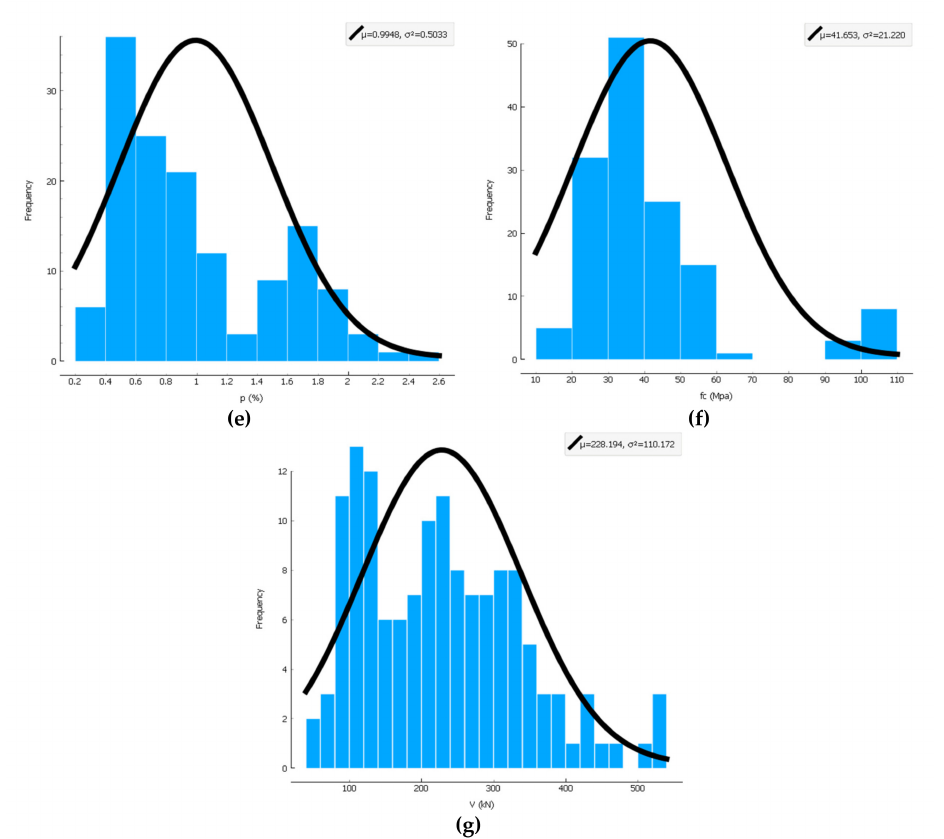
Figure 1. Histogram chart for all data, including ( a ) the e ff ective depth of the slab, ( b ) the depth of the slab, ( c ) the length of the column, ( d ) the fiber volume, ( e ) the reinforcement ratio, ( f ) the compressive strength of the concrete, ( g ) the punching shear